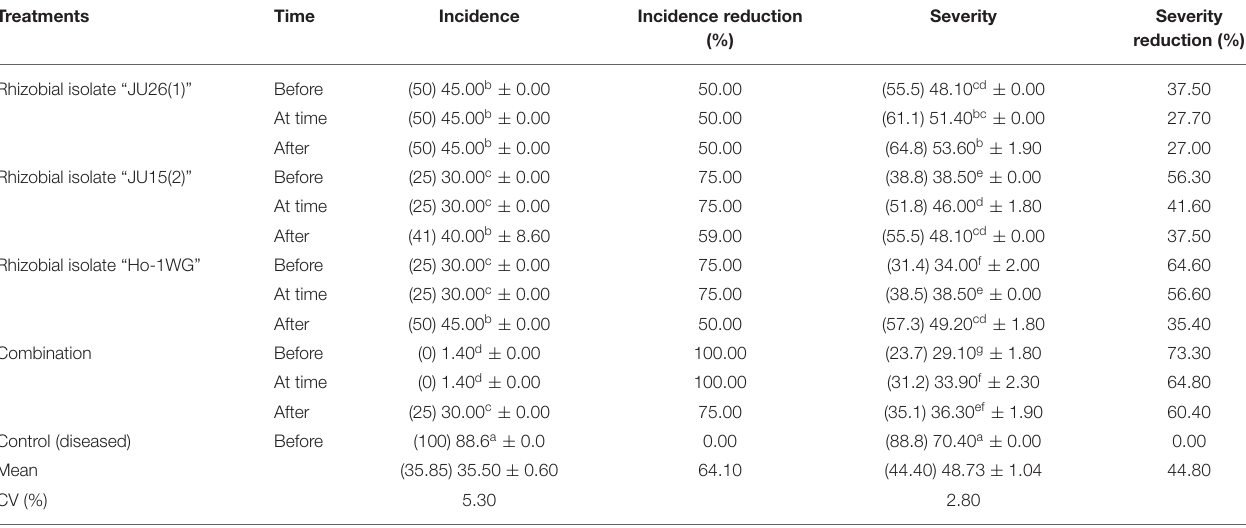
Severity Severity (%) reduction (%)